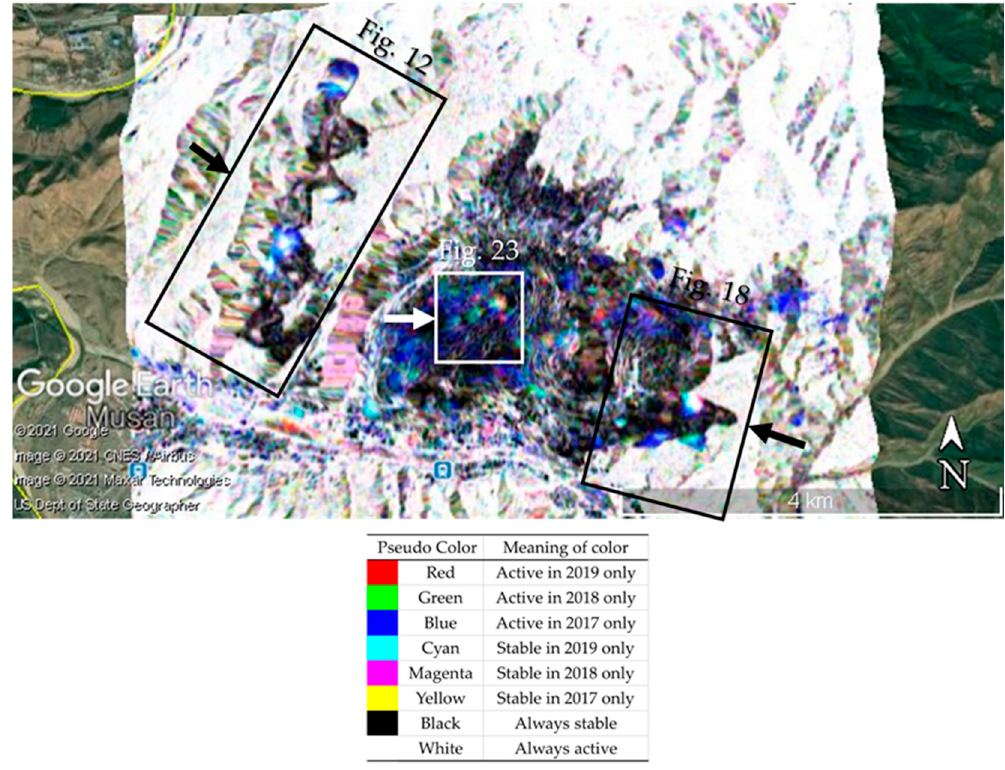
Figure 11. RGB composite of the annually averaged NDAI map (R: 2019, G: 2018, and B: 2017). Square boxes are the regions for the denoted figures, and arrows are the viewing directions.